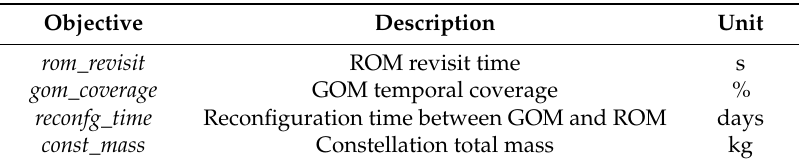
Table 6. Objectives of ReCon